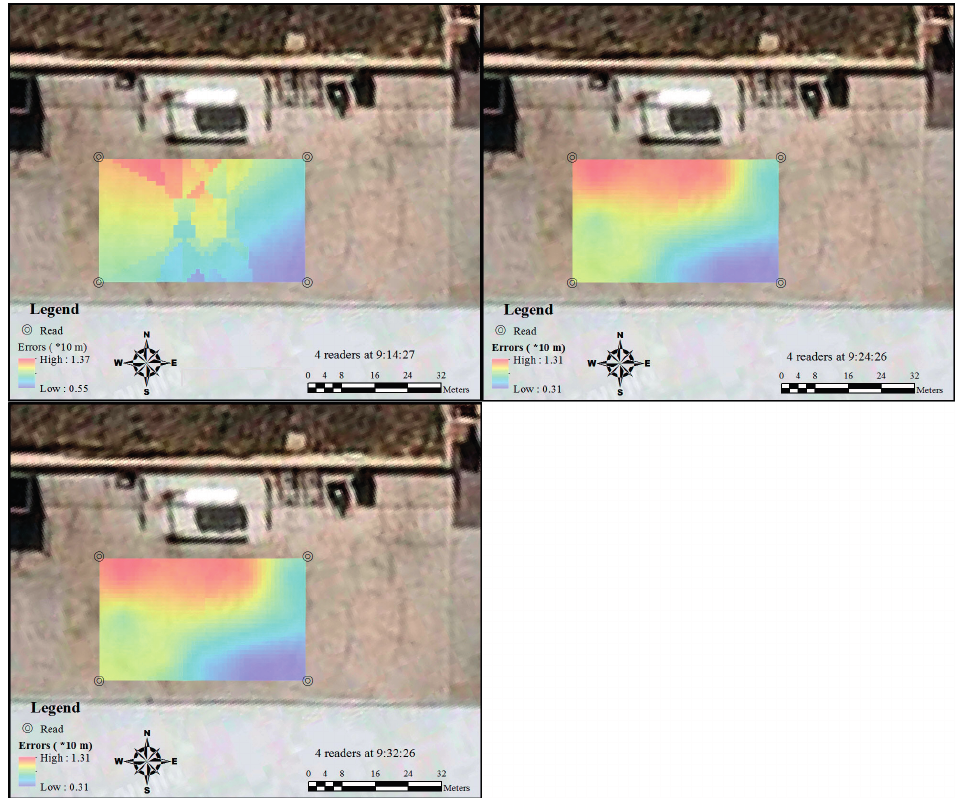
Figure 8. Spatial and temporal variation of RFID errors distribution by four readers.